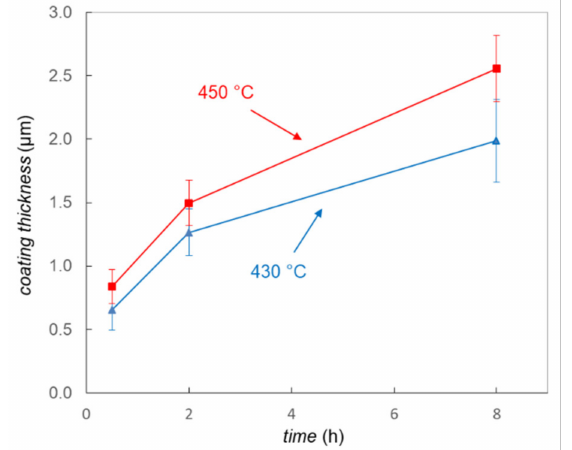
Figure 4. MgF 2 fluoride conversion coating thickness dependence on the coating